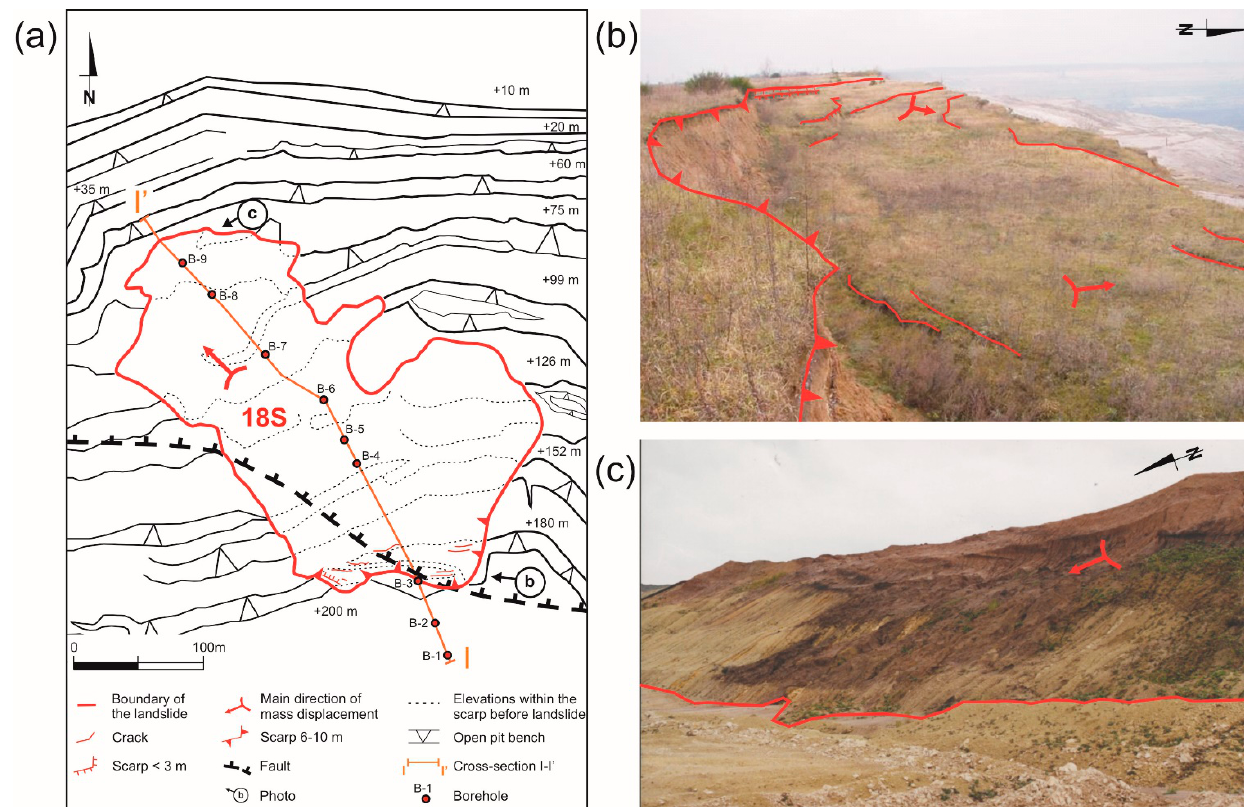
Figure 3. ( a ) Sketch of 18S landslide; ( b ) crown and main scarp of the landslide on the level +205 m a.s.l.; ( c ) colluvium fragment on the level +78 m (photo by R. Kaczmarczyk).